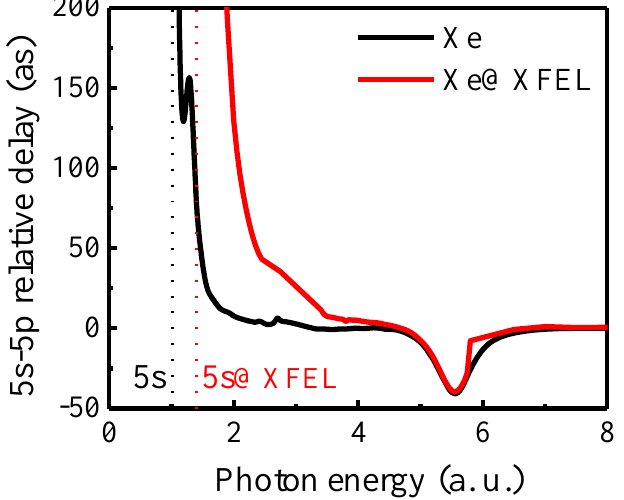
Figure 18. The time delay difference of 5s and 5p subshell (τ(5s)-τ(5p)) of Xe (black) and Xe@XFEL (red) in the RRPA calculation. Vertical lines show the 5s subshell threshold for Xe (black) and Xe@XFEl (red).